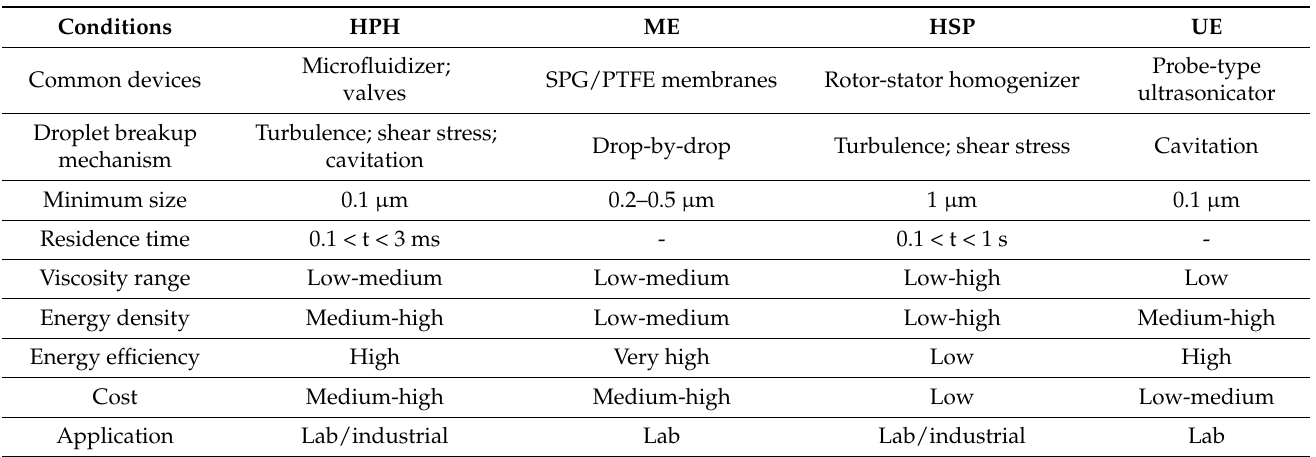
Table 3. Comparison of different high-energy